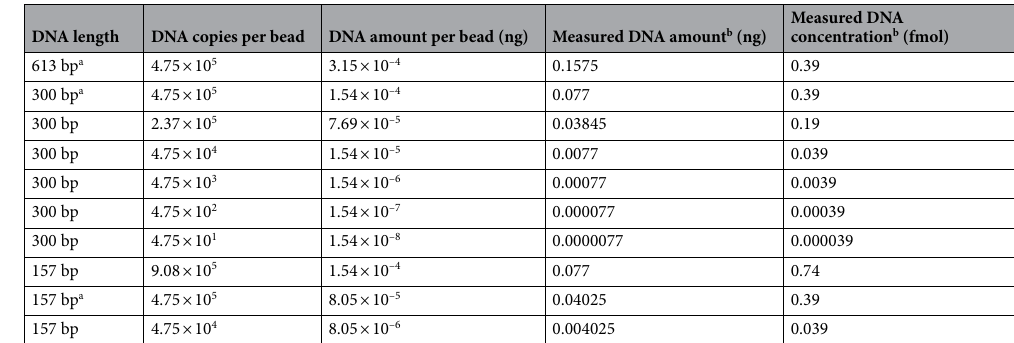
Table 1. DNA samples analyzed. a 3 samples selected to study the effect of DNA length on impedance response (see Fig. 4). b For each sample, measurements were performed using an aliquot of approximately 500